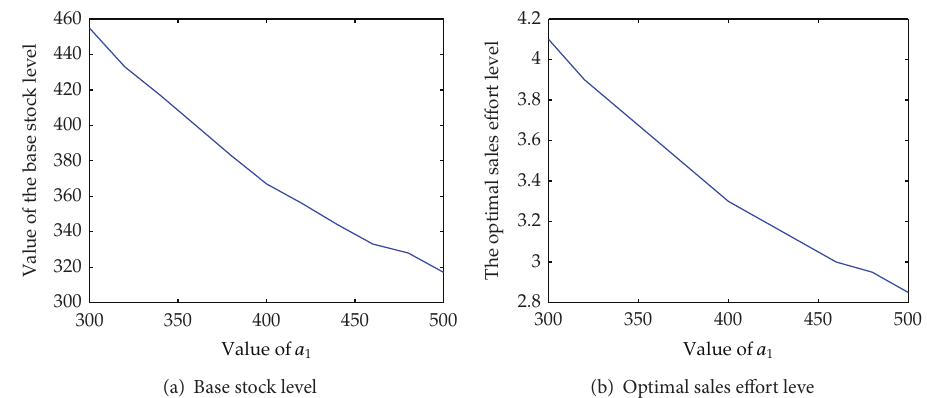
Figure 2: An illustration of the optimal policies with respect to sales effort cost.